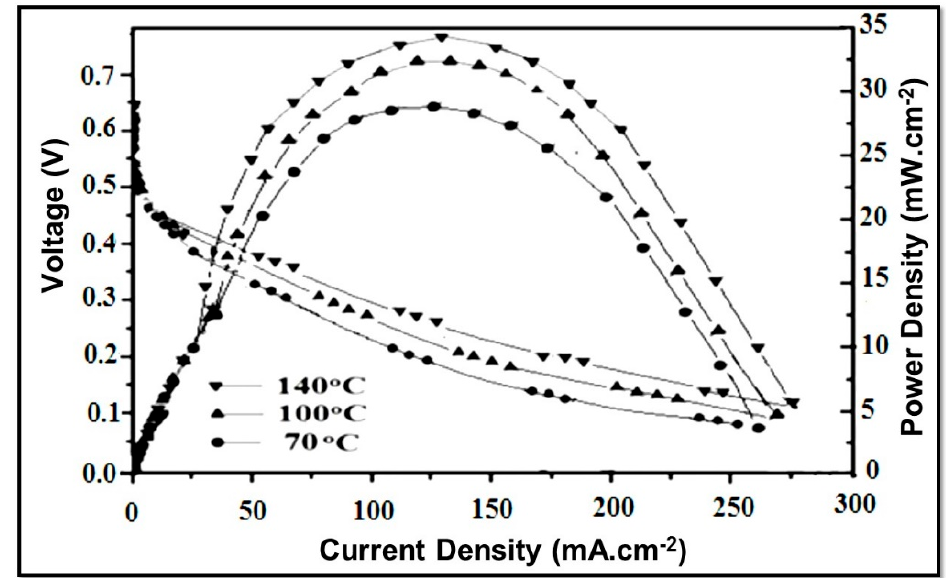
Figure 8. Evaluation of NSPI 10 membrane in DMFC at various indicated temperatures.